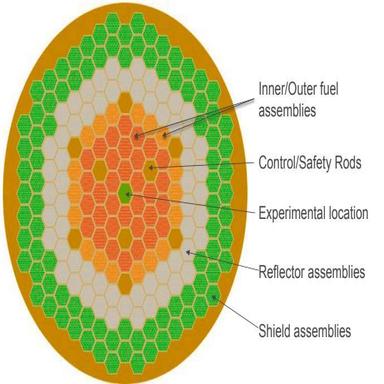
Cross section of the SFR reactor design and main features.